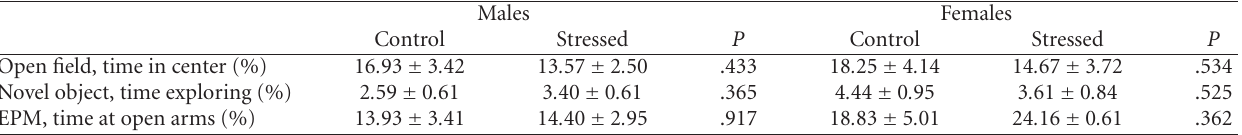
Table 1: E ff ects of stress prior to puberty in the activity (open field and reactivity to novelty) and anxiety-like responses in the elevated plus maze (EPM) displayed by male and female rats during adolescence (P39-40). (Results are the mean ± SEM of n = 10 to 6 animals per group.) Males Females Control Stressed P Control Stressed P Open field, time in center